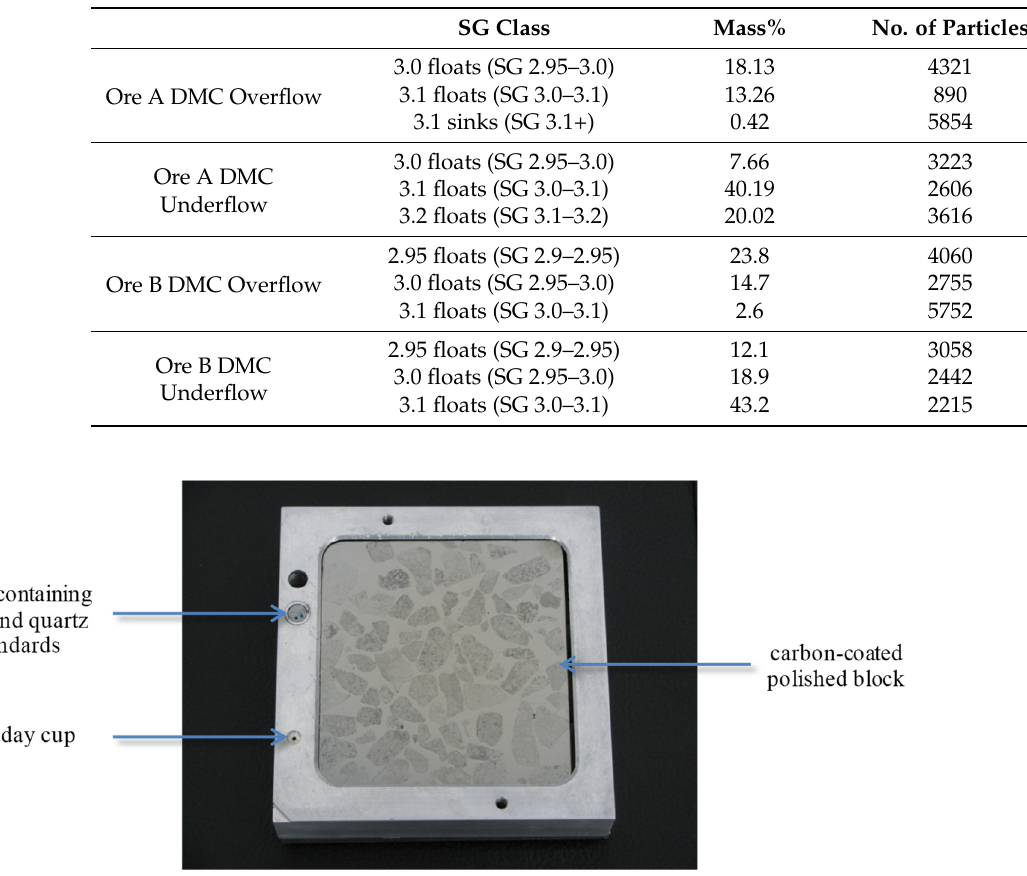
Figure 2. Sample holder containing the carbon-coated polished block (75 mm × 80 mm) used for the analysis.